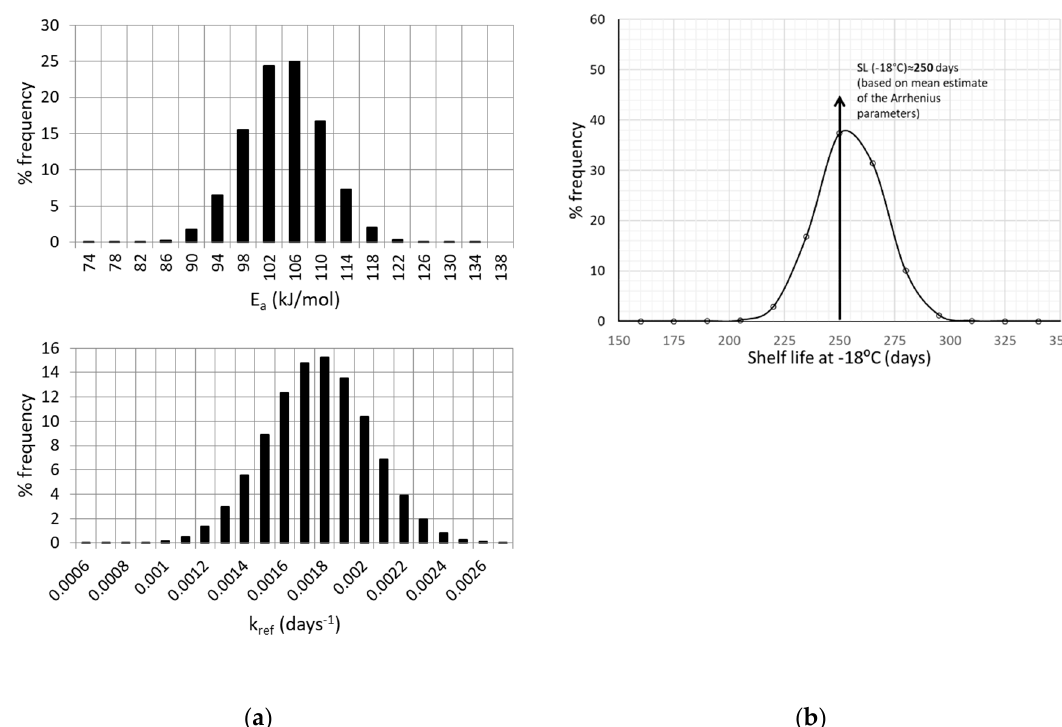
Figure 2. ( a ) Normal distribution of E a and k ref values, based on the mean value and the standard deviation estimated by the one-step non linear analysis and ( b ) Shelf Life estimated at − 18 °C.